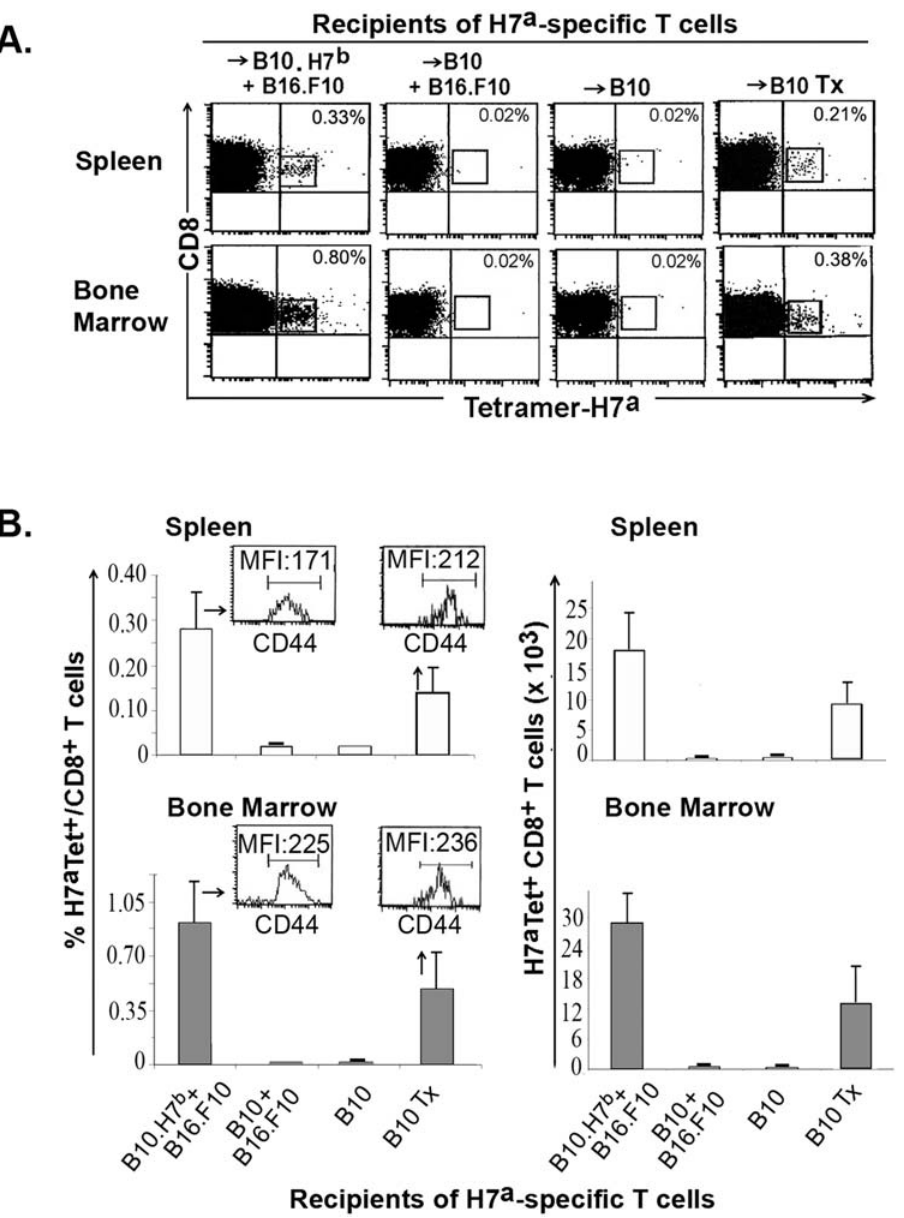
Figure 4. Persistence of H7 a -specific CD8 + memory T cells. We studied four experimental groups: i) B10.H7 b and B10 mice successfully treated for melanoma as described in Fig. 1 ( + B16.F10); ii) euthymic and thymectomized (Tx) B10 mice that underwent the same protocol excepting injection of melanoma cells on day 0. On day 100, we sacrificed 3 mice per group and stained cell suspensions from spleen and bone marrow with H7 a tetramers and antibodies against CD8 and CD44. A) Dot plots of one representative experiment out of three (gated on CD8 cells). B) Proportion and absolute number of H7 a -specific T cells in recipients’ spleen and bone marrow (2 tibiae and femurs). Histograms represent the mean 6 SD of 3 mice per group. Inserts depict CD44 expression on tetramer + CD8 T cells found in euthymic B10.H7 b and thymectomized B10 hosts. MFI: mean fluorescence intensity.